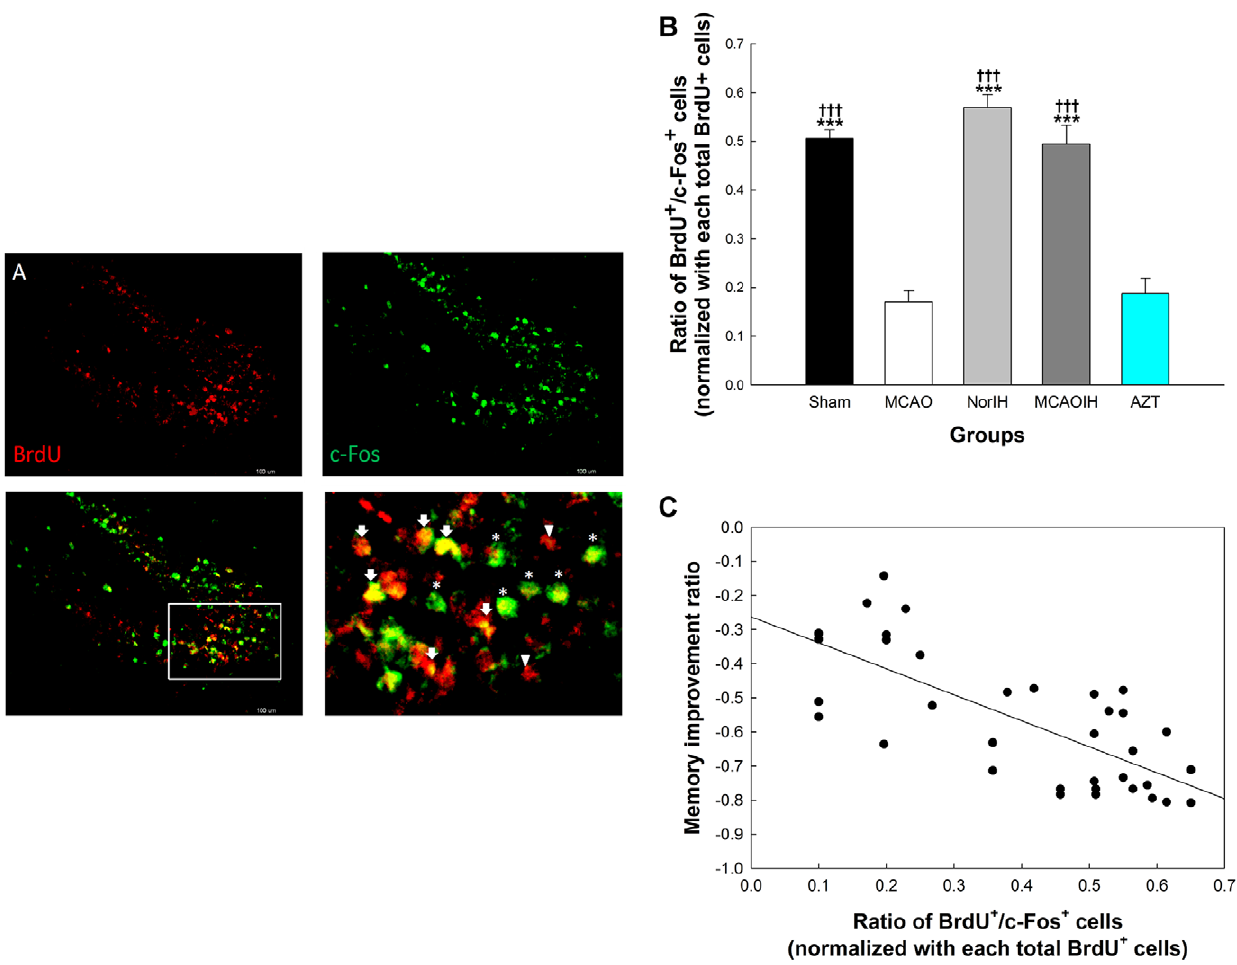
Figure 4. Post-ischemia IH intervention enhanced the activity of newborn cells, as indicated by c-Fos expression. Newborn cell activity correlated significantly with spatial memory improvement. (A) BrdU (red; upper left) and c-Fos (green; upper right) staining in the DG (bar, 100 m m). The lower right image is a 40 6 magnification of the region boxed in white (lower left). BrdU 2 /c-Fos + cells are indicated by stars. BrdU + /c-Fos + cells are indicated by arrows. BrdU + /c-Fos 2 cells are indicated by arrowheads. (B) Quantification of BrdU + /c-Fos + double-labeling. (C) Correlation of the number of BrdU + /c-Fos + double-labeled cells with memory improvement ratios. *** p , 0.001 compared to the AZT group. {{{ p , 0.001 compared to the MCAO group.